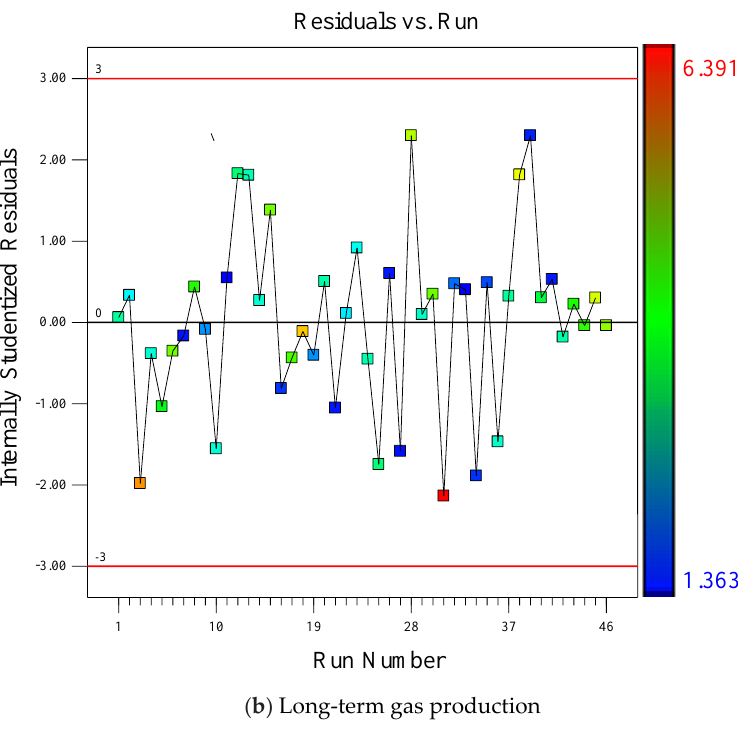
Figure 11. Studentized residuals versus run number at different production periods.